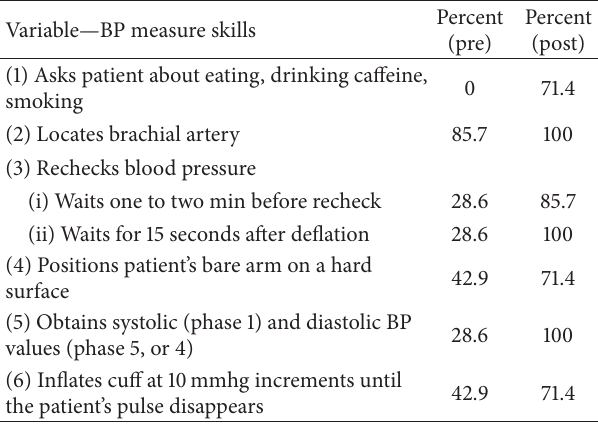
Table 4: Proportion of participants’ perceived responses on the attitudes pre-post test using Respondents’ Attitude to Assessment Strategies for Prevention of High Blood Pressure